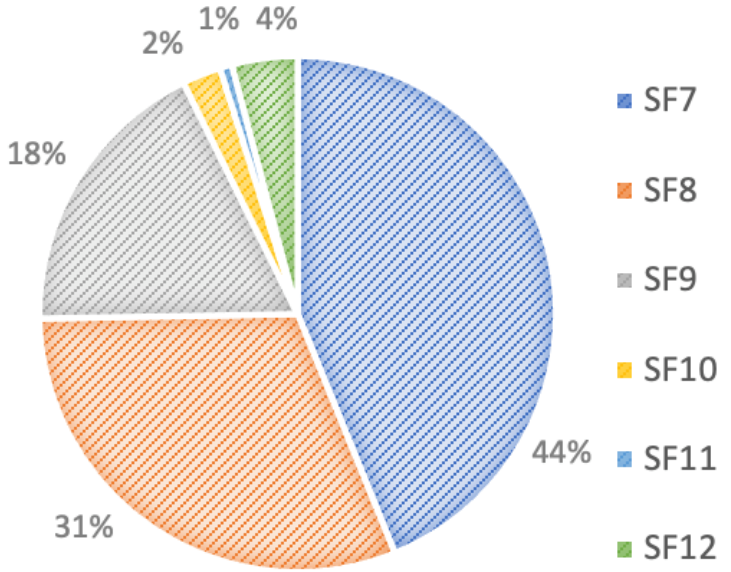
Figure 10. Received traffic for SFs over 25 km² with water